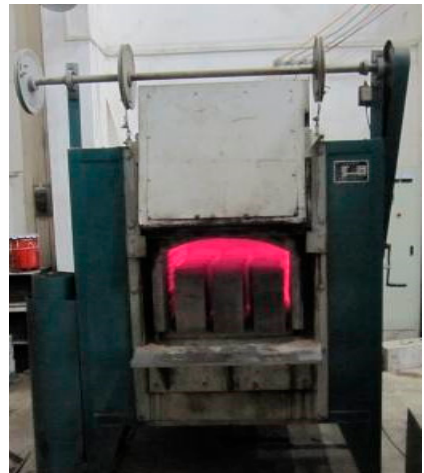
Figure 2. Heating equipment.